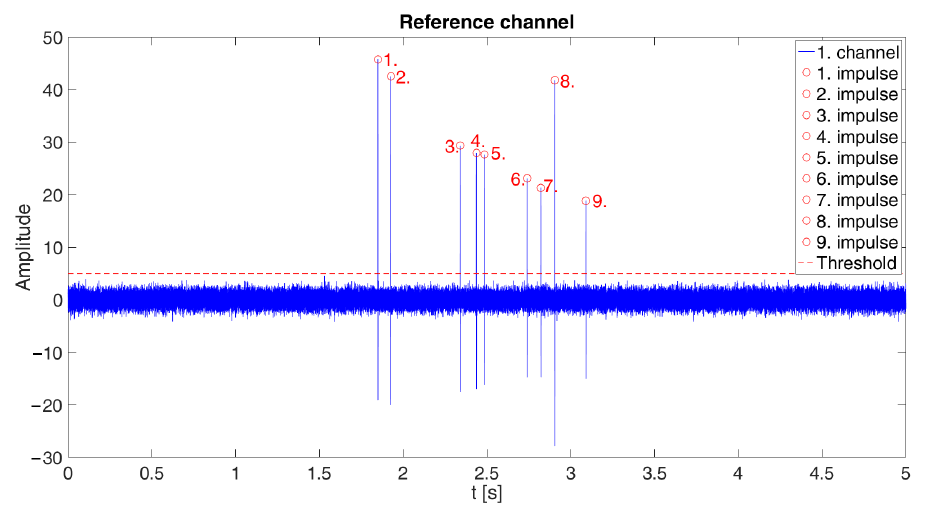
Figure 9. Acquired signal in the reference